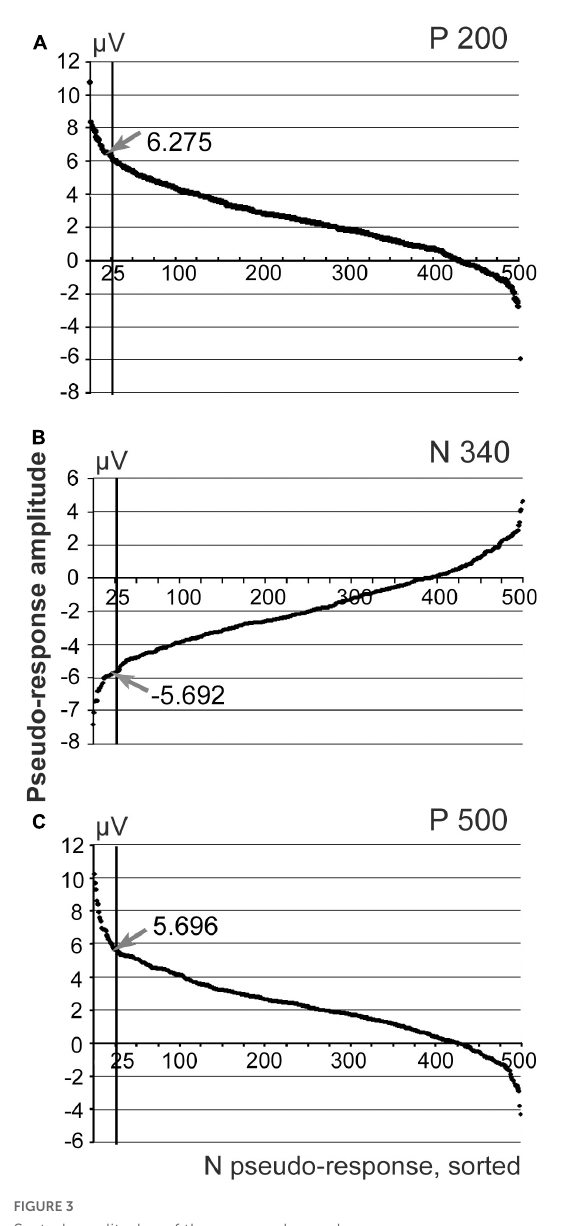
FIGURE3 Sorted amplitudes of the averaged pseudo-responses, n permutations = 500. (A) Distribution of pseudo-responses for the interval corresponding to P200 component of the evoked response; (B) N 340 interval; (C) P500 interval. Arrows demonstrate the amplitude values obtained for the real evoked